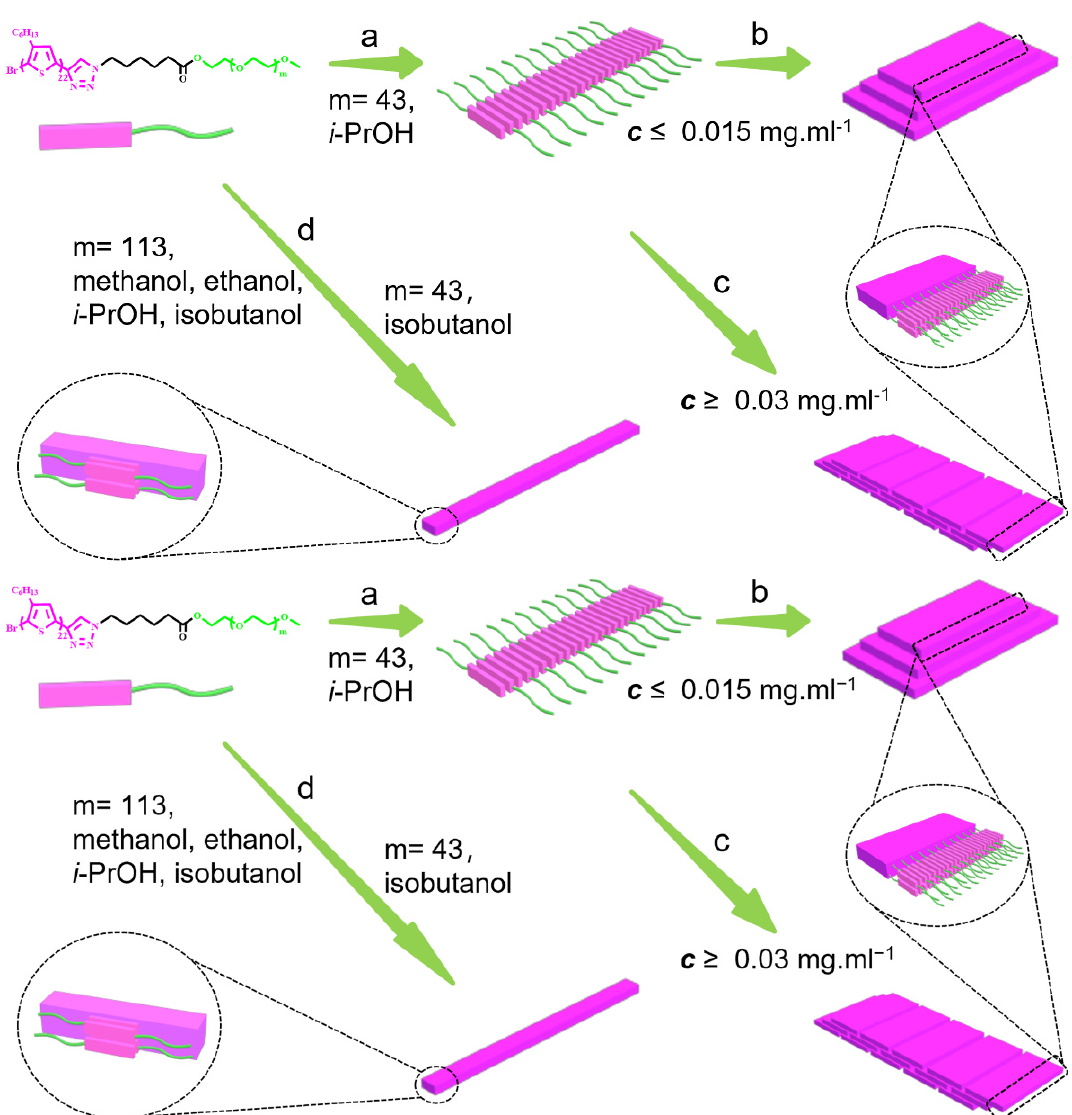
Figure 4. The probable formation processes of the nanostructures self-assembled by P3HT 22 - b -PEG m , (a) the transition fibers formed by P3HT 22 - b -PEG 43 in i -PrOH during the cooling process, (b) the multilayered hierarchical micelles formed by P3HT 22 - b -PEG 43 in i -PrOH when the polymer concentration is beblow 0.015 mg . mL − 1 , (c) the hierarchical micelles with linearly arranged 2D laminar layers formed by P3HT 22 - b -PEG 43 in i -PrOH when the polymer concentration is above 0.03 mg.mL − 1 , (d) the fibers formed by P3HT 22 - b -PEG 43 in isobutanol, or the fibers formed by P3HT 22 - b -PEG 113 in methanol, ethanol, i -PrOH and